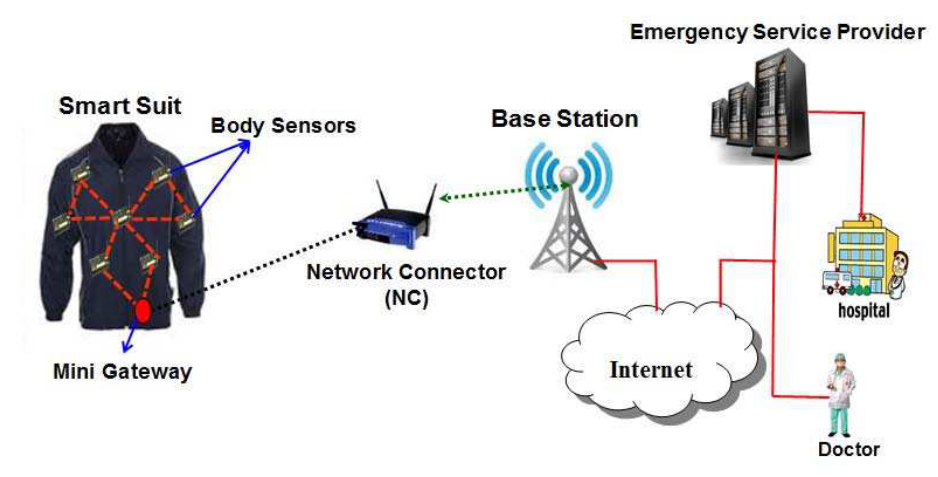
Figure 2. Communication architecture of three tier Wireless Body Sensor Networks for indoor mHealth